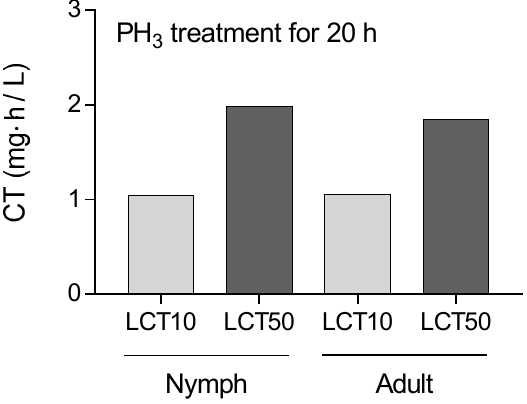
Figure 1. Effects of phosphine fumigation on the different developmental stages of Myzus persicae . Lethal concentration time (LCT) values are obtained using Equation (1). More details in mortality are shown in Figure S1 and Table S2.